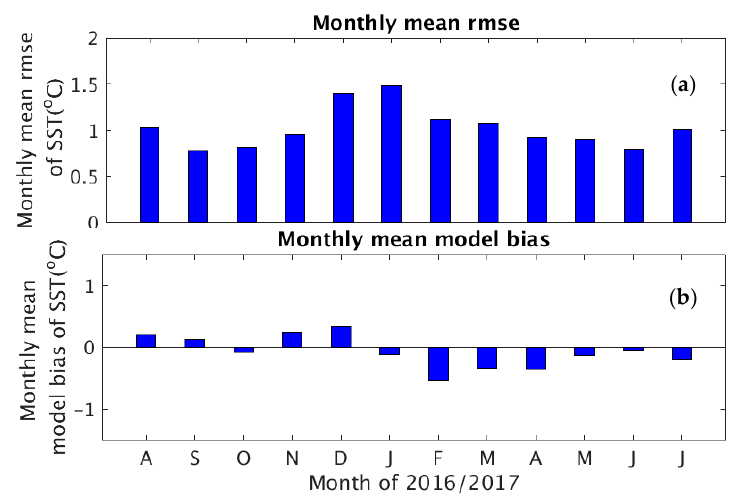
Figure 14. Monthly mean ( a ) RMSE and ( b ) the absolute model-date differences of the hindcast SST.